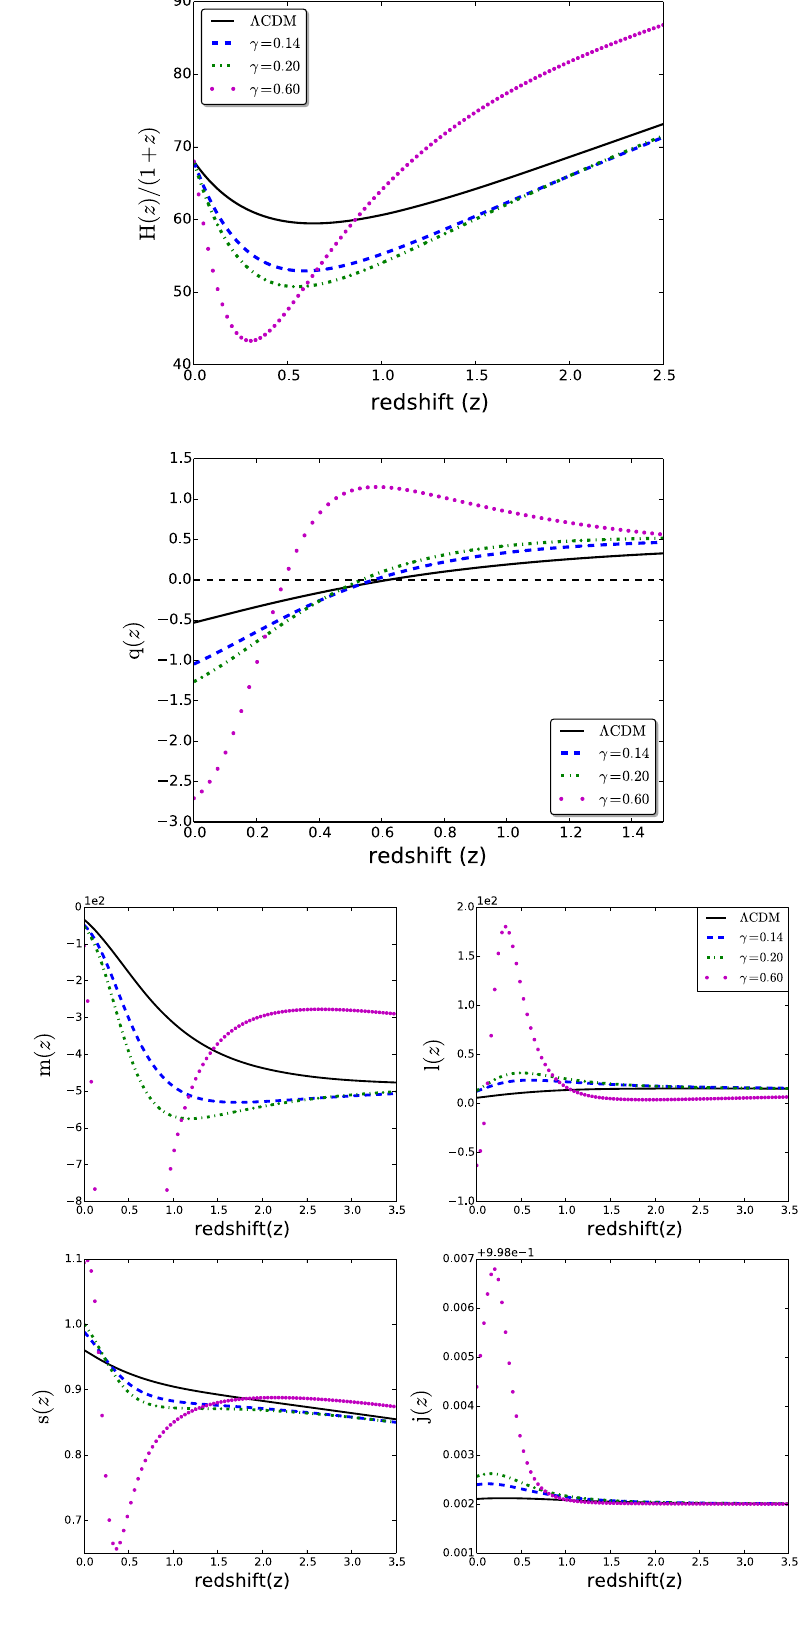
Fig. 9 Upper panel the H ( z ) ( 1 + z ) as a function of the redshift. Middle panel deceleration probe diagnostic. Lower panel jerk , snap , lerk and maxout parameters for the bulk viscous model with respect to Λ CDM model. Solid lines represents corresponding quantity for Λ CDM. Other lines are associated with different values for viscosity. The rest of free parameters have been fixed according to JLA observation at 1 σ confidence